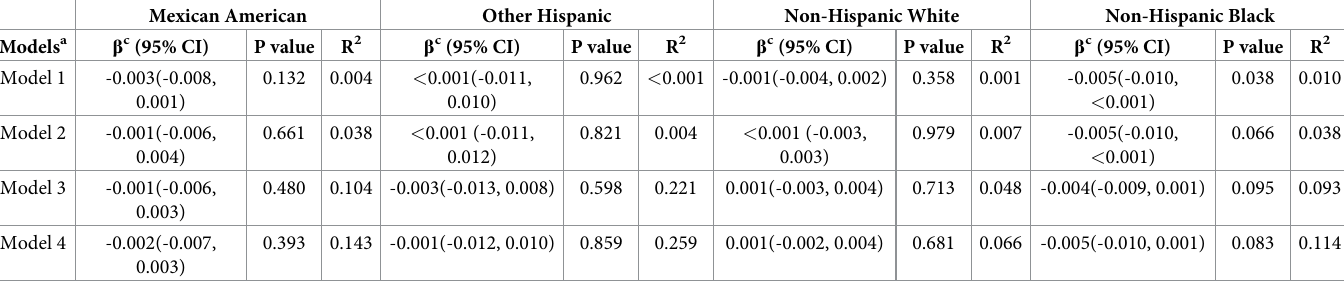
Table 4. Ethnicity difference in association between level of vitamin D and measles antibody titer in seropositive b subjects. Mexican American Other Hispanic Non-Hispanic White Non-Hispanic Black Models